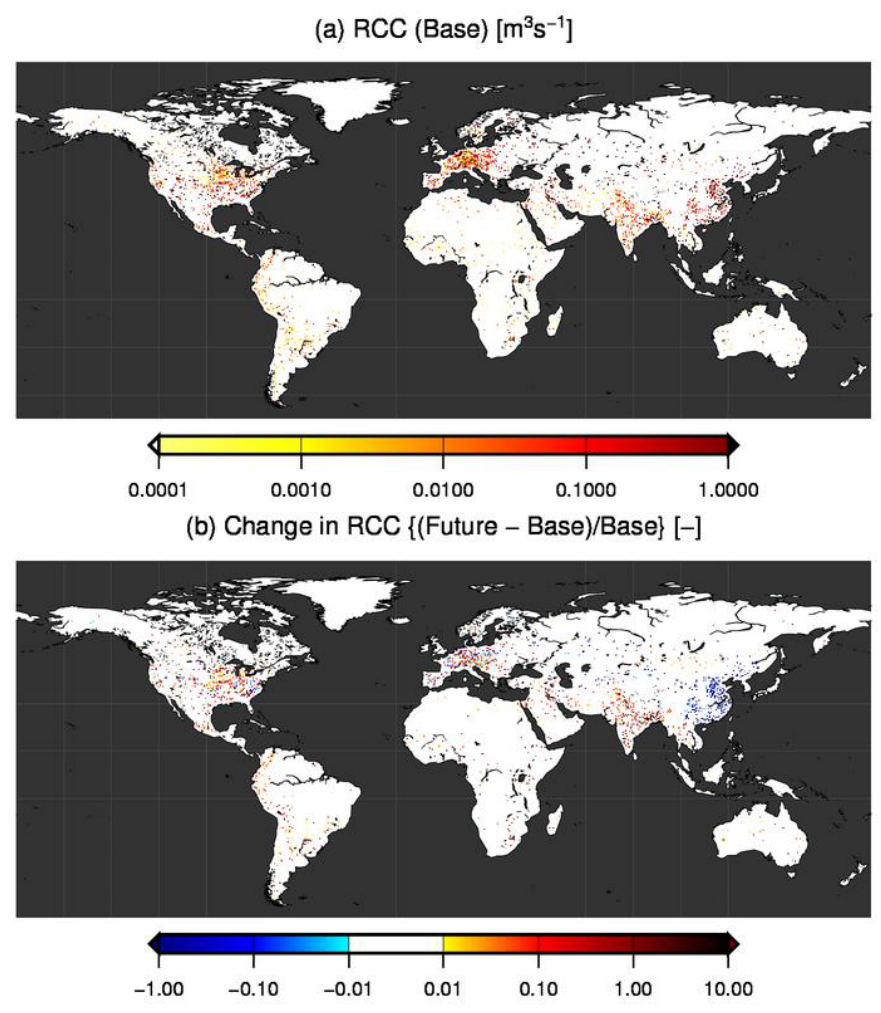
Figure 3. Distribution of consumptive water use for thermal power generation. ( a ) Distribution of consumptive water use in 2006. ( b ) Distribution of the change (rate) in consumptive water use in the future period (2080–2099) compared to the base period (2006–2025) for the BAU scenario.